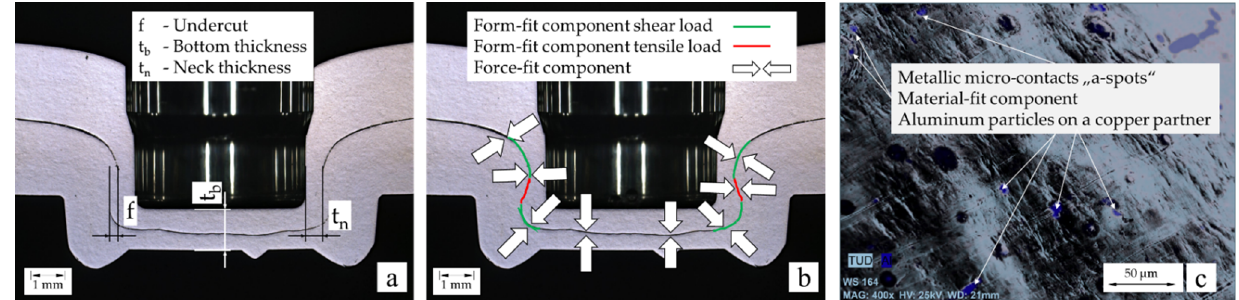
Figure 2. ( a ) Characteristic designing parameters, ( b ) closure types of a clinched joint, ( c ) EDX analysis of surface.